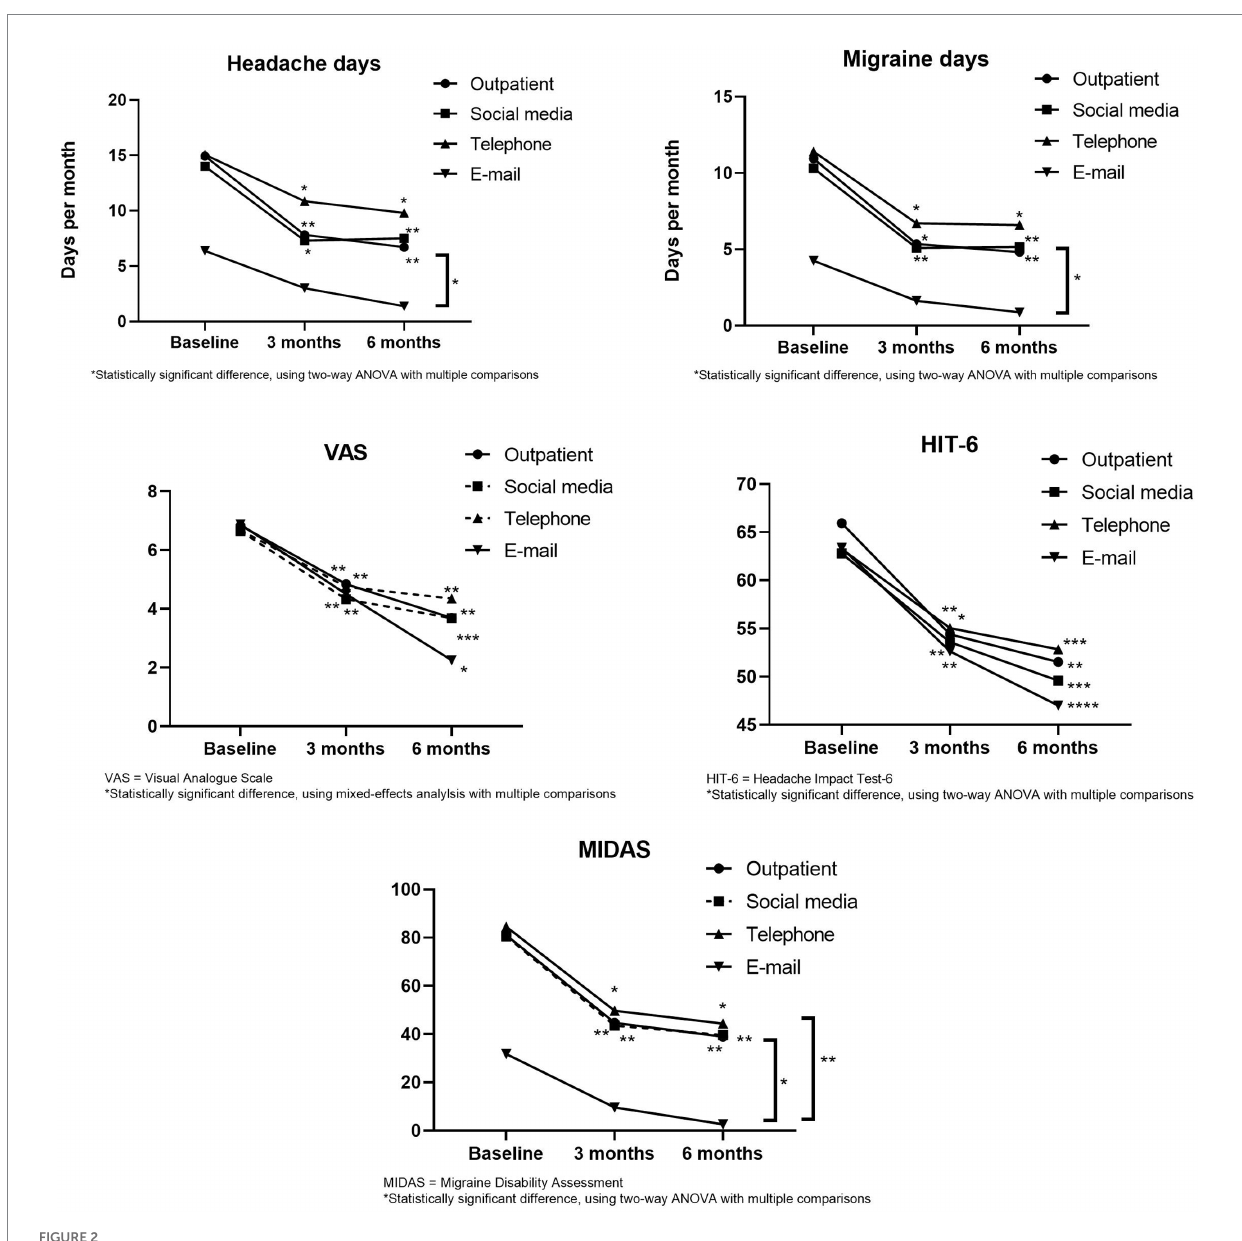
FIGURE 2 Headache days, migraine days, VAS, HIT-6 and MIDAS during 6